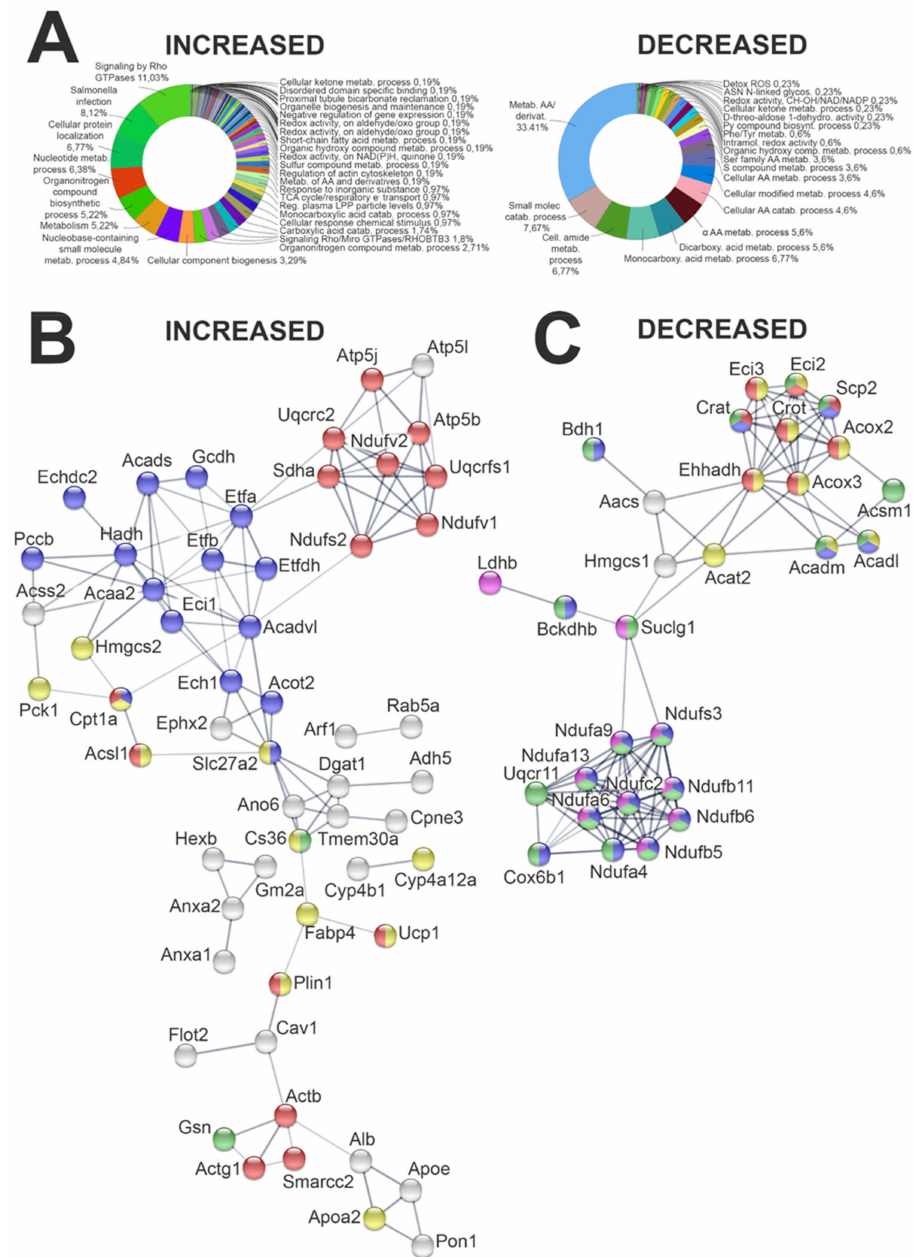
Figure 4. Bioinformatic analysis of the proteins increased and decreased in the comparison between the high-fat and normal chow groups. ( A ) Bioinformatic analyses by Cluego software (Cytoskape release 3.8.2) within the set of increased and decreased proteins. Functional grouping was based on p value ≤ 0.05. GO terms fusion allowed at least 3 counts. ( B ) Proteins increased and identified by Cluego as involved in lipid metabolism were analyzed by String (version 11.0). For clarity, the figure reports only proteins linked in a network. The color indicates proteins involved in a specific process: fatty acid catabolic process (blue), thermogenesis (red), amyloid fibril formation (green), and perox- isome proliferator-activated receptors (PPAR) signaling pathway (yellow). ( C ) Proteins decreased and identified by Cluego as involved in lipid metabolism were analyzed by String (version 11.0). For clarity, the figure reports only proteins linked in a network. The color indicates proteins involved in a specific process: peroxisome (red), mitochondria (green), mitochondrial envelop (blue), fatty acid beta oxidation (yellow), tricarboxylic acid cycle (TCA), and electron transport